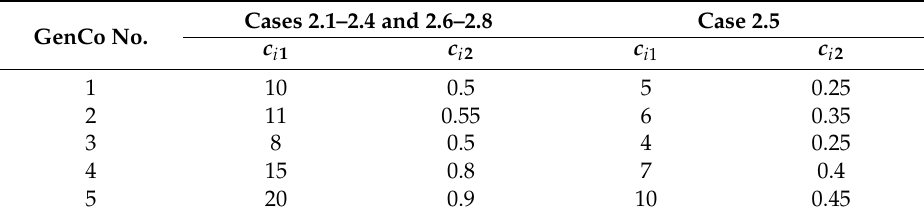
Table 3. GenCos’ cost parameters. (Unit for c i 1 : $/MW, unit for c i 2 : $/(MW) 2 ). GenCo